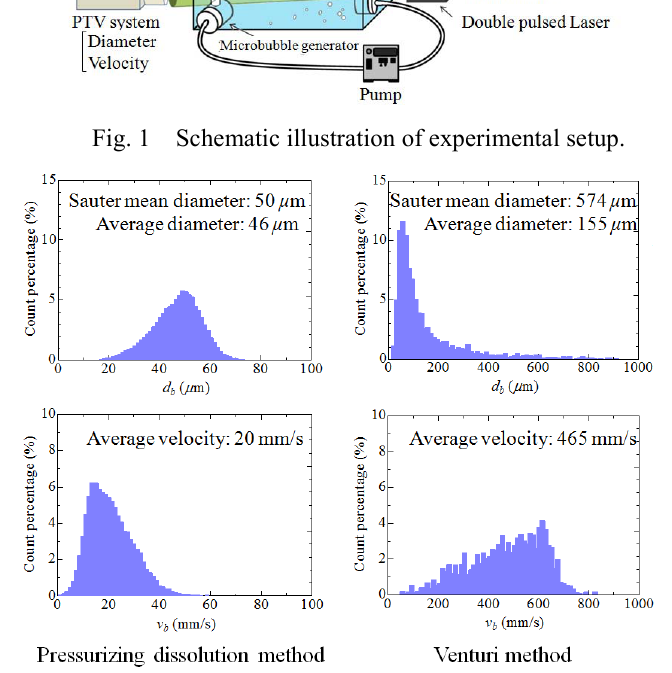
Fig.2 Histograms of bubble diameter and